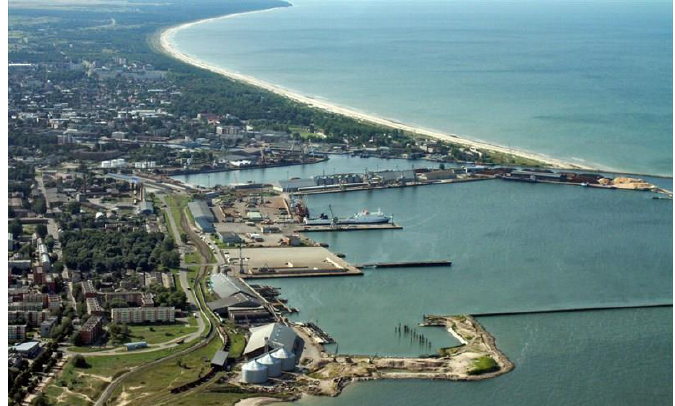
11 of 30 Figure 5. Port of Ventspils. Source: [70]. The port is a useful transport link between the EU, the CIS and the Central Asia and is considered one of the main network nodes in Latvia and the Baltic Sea region be- tween the East – West transit corridor and the European TEN-T transport network. The main characteristics of the port are as follows: •